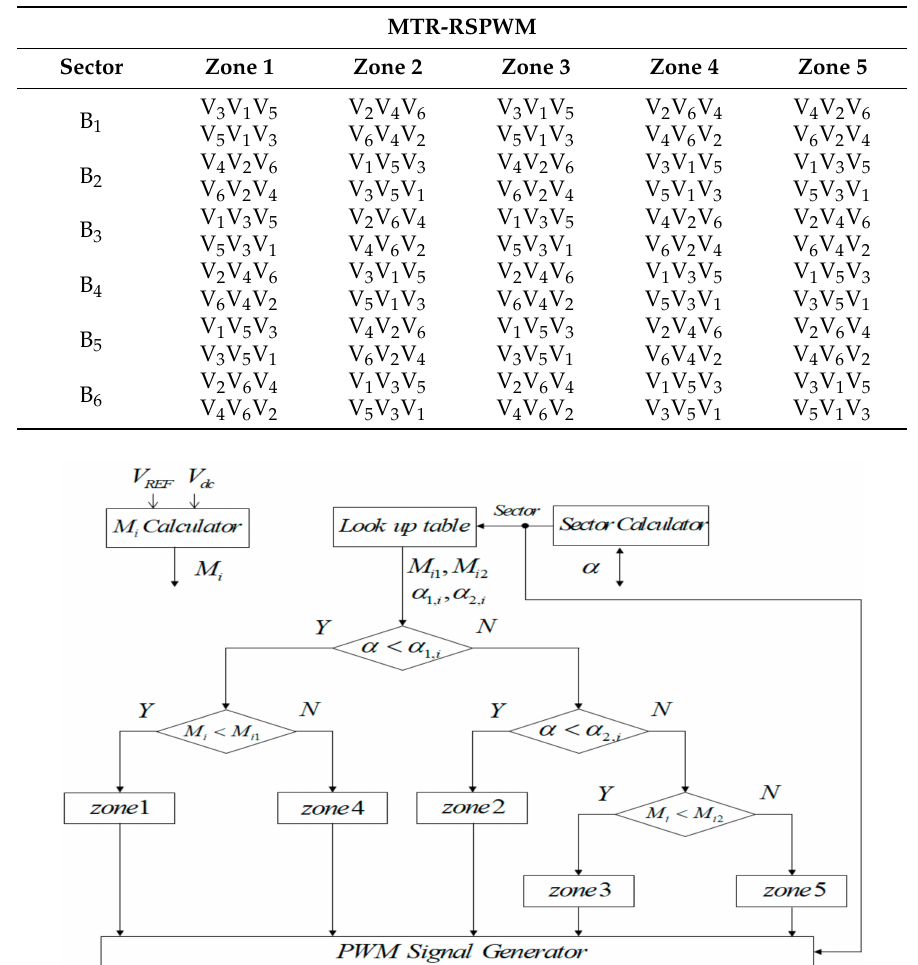
Table 3. Pulse Patterns of the MTR-RSPWM.